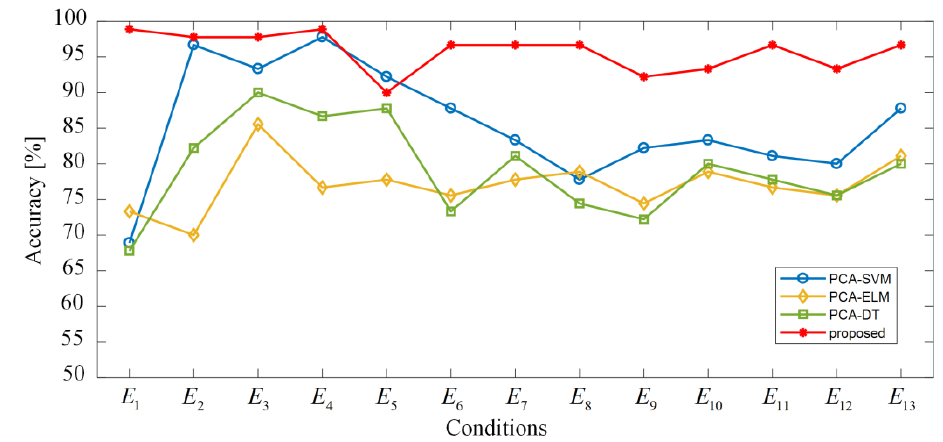
Figure 10. Accuracy of different fault diagnosis strategies under 13 variable conditions.